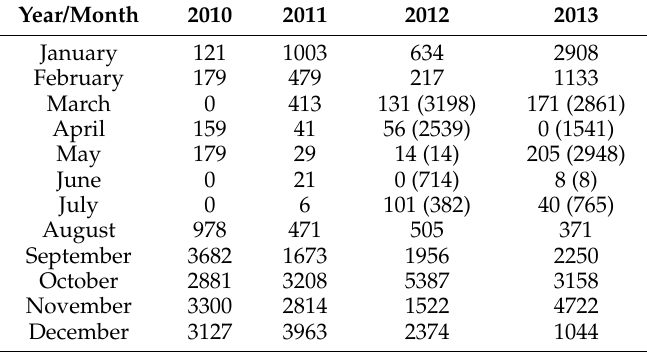
Table 1. Monthly-compiled squid fishing points detected from the daily DMSP/OLS night-time visible images from January–December, 2010–2013. The values in parenthesis are the augmented squid fishing locations from the DMSP/OLS and NPP/VIIRS